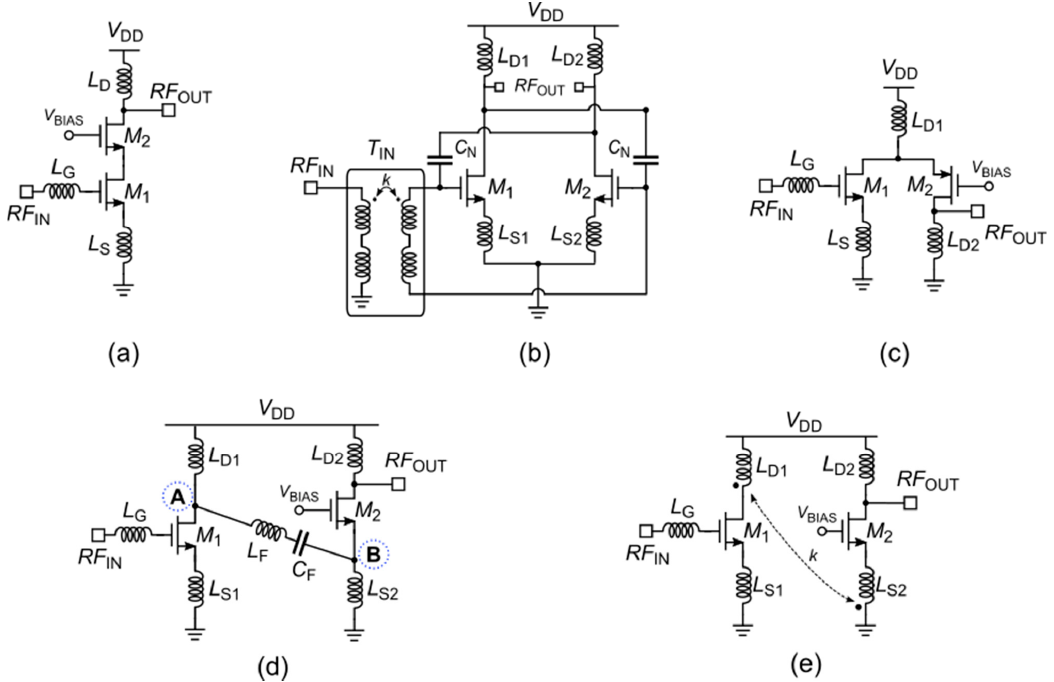
Figure 5. ( a ) Cascode; ( b ) neutralized common source (CS); ( c ) folded cascode; ( d ) capacitive-coupled (CC) cascode; ( e ) transformer-coupled (TC) cascode.